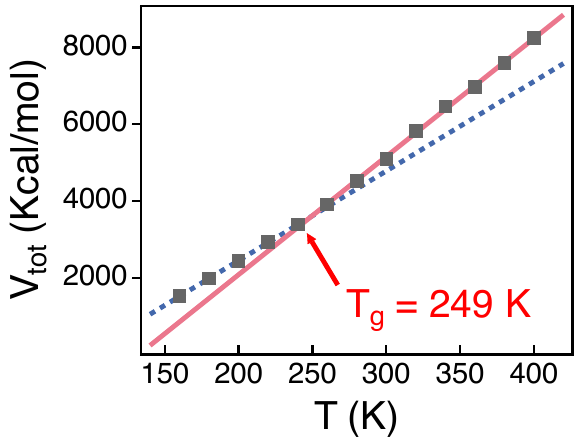
Figure 1. Simulation results for the total potential energy ( V tot ) of the simulation systems as a function of temperature T . A solid line and a dashed line are linear fits to V tot ’s for the temperature ranges of 300–400 K and 160–230 K, respectively. The intersection of two fitting lines is estimated to be T g . The statistical errors are smaller than the markers.